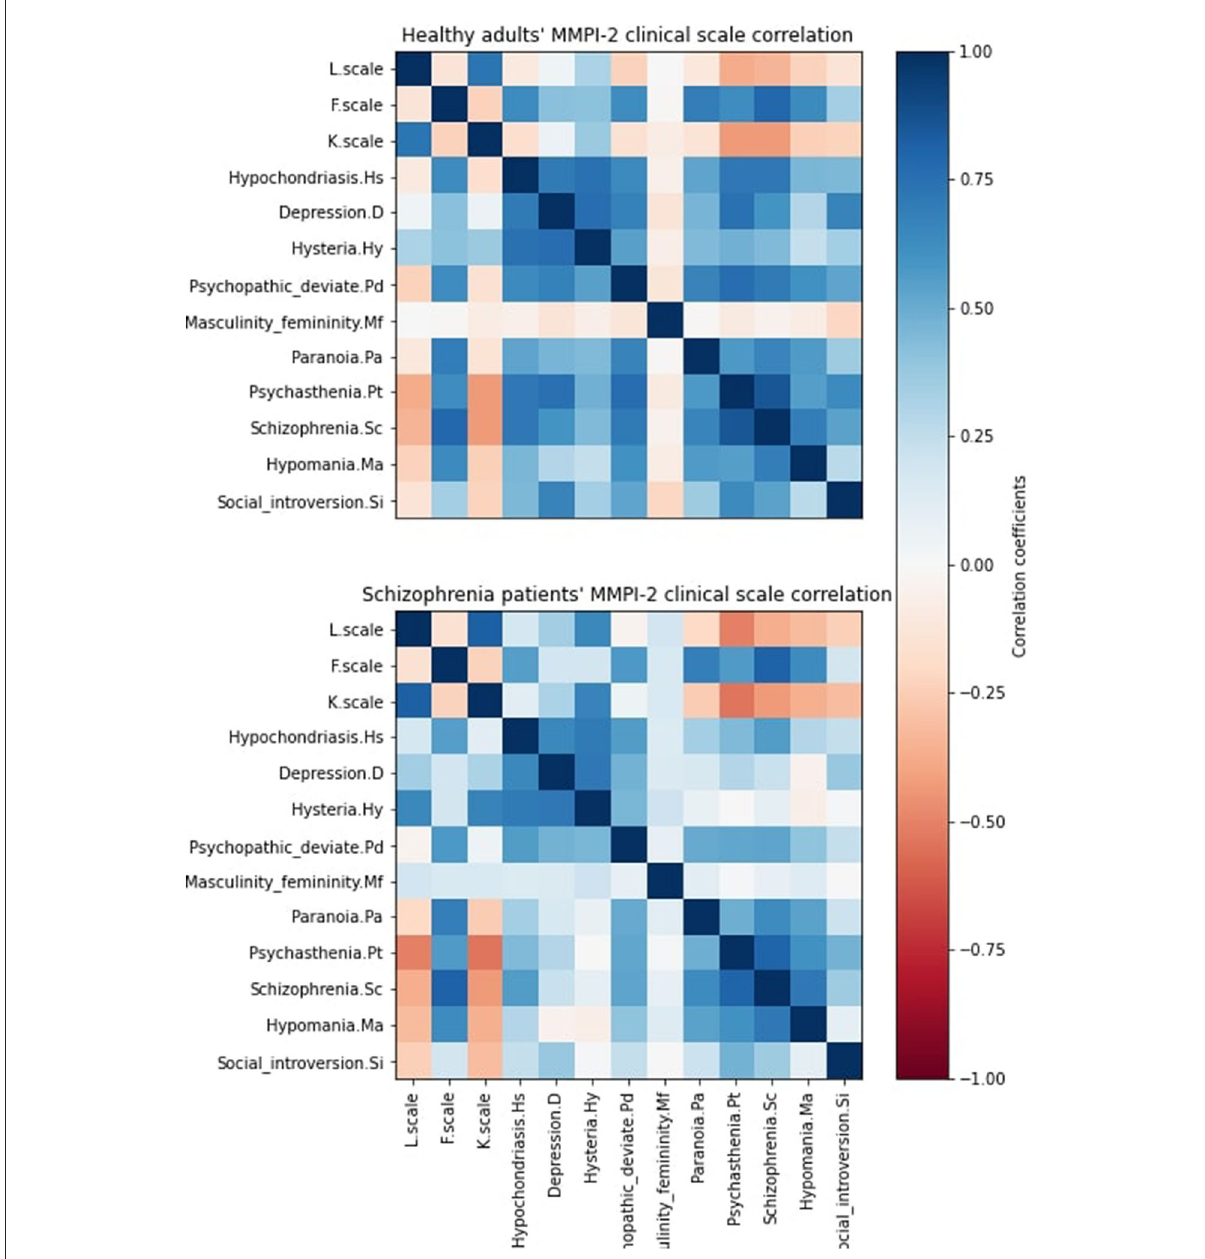
FIGURE2 MMPI-2 correlation matrix of healthy adults (top) and patients with schizophrenia (bottom). The correlation coefficient is calculated by Pearson correlation